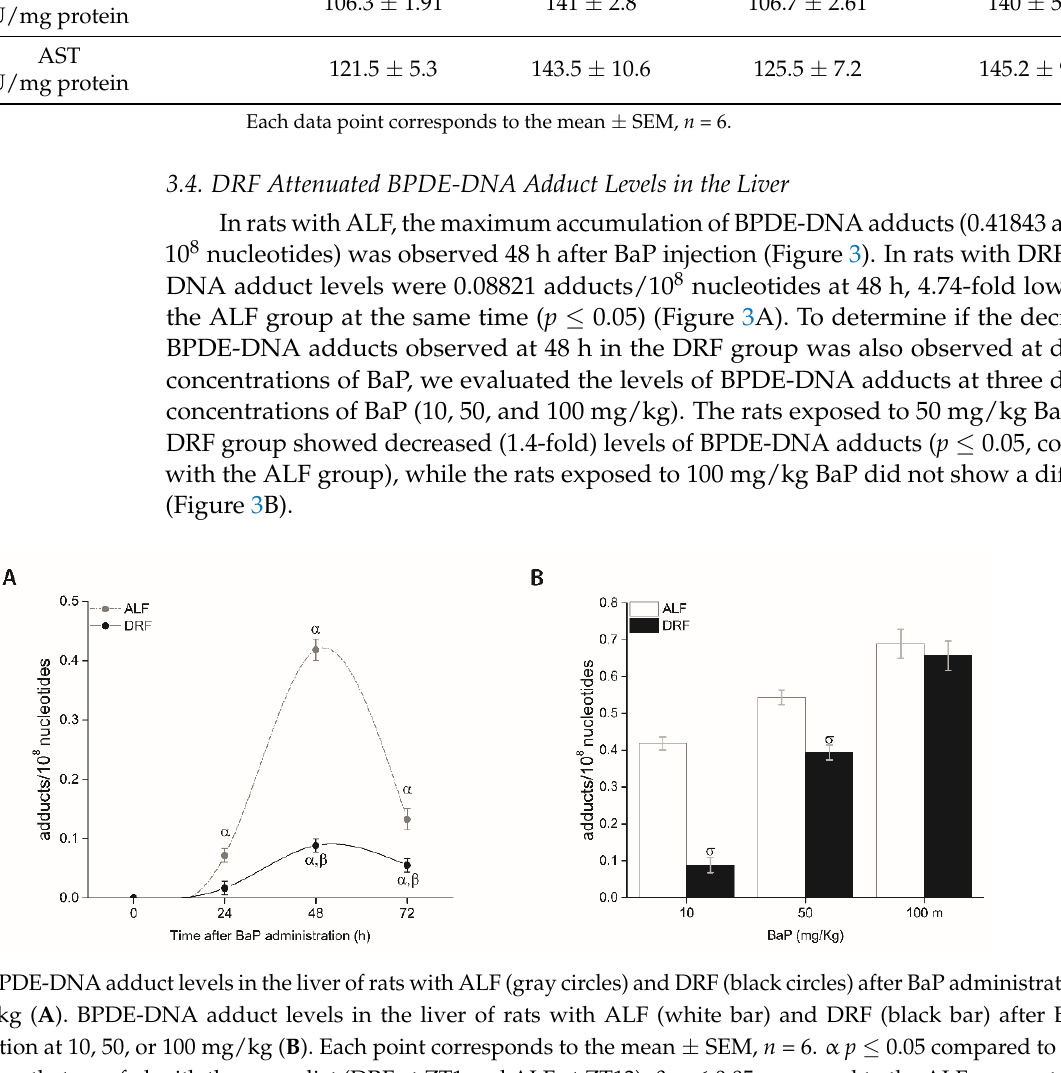
Each data point corresponds to the mean ± SEM, n = 6.